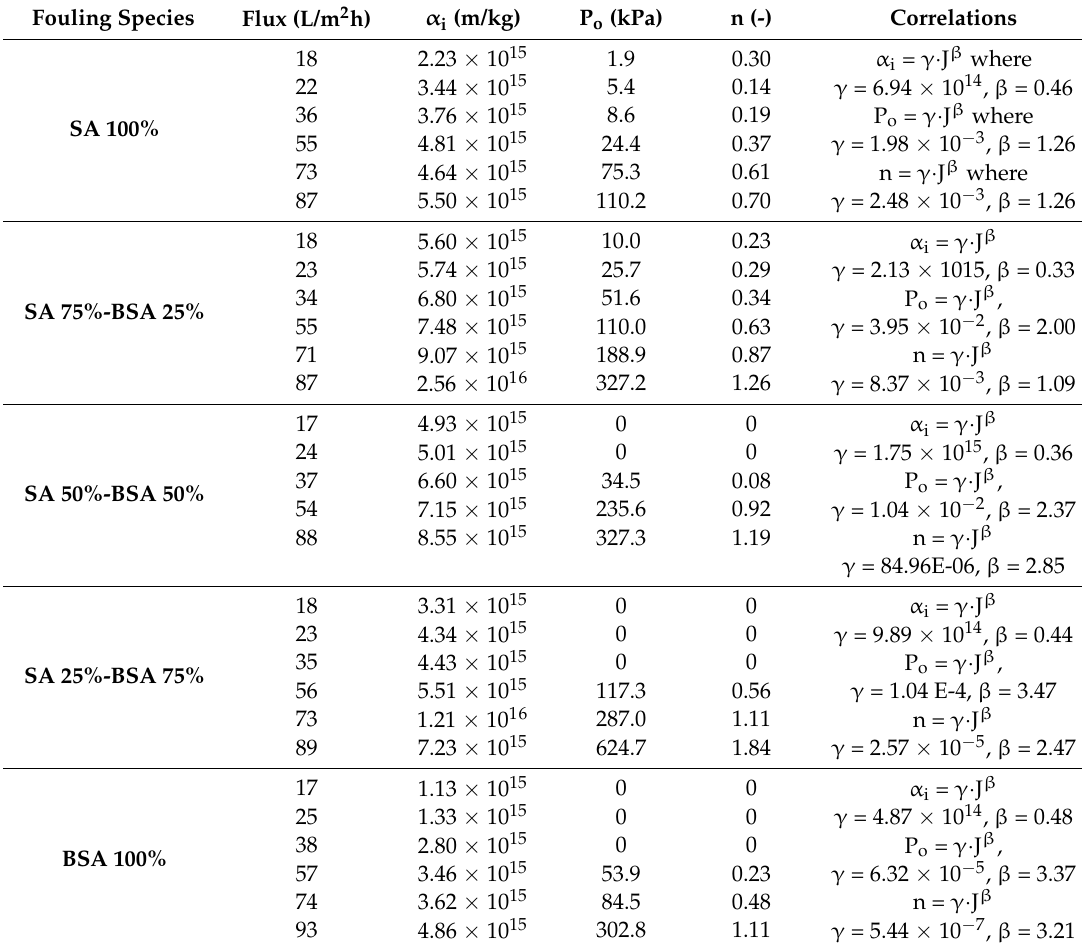
Table A1. Correlation of UF fouling resistance α data; fitting